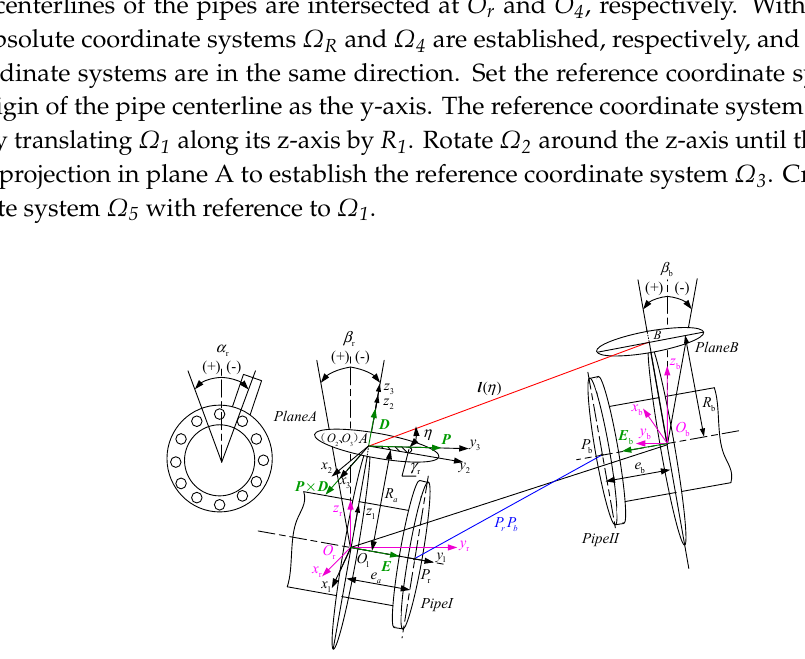
Figure 2. Mathematical model I of the measuring device based on the outer circle positioning of the pipeline.